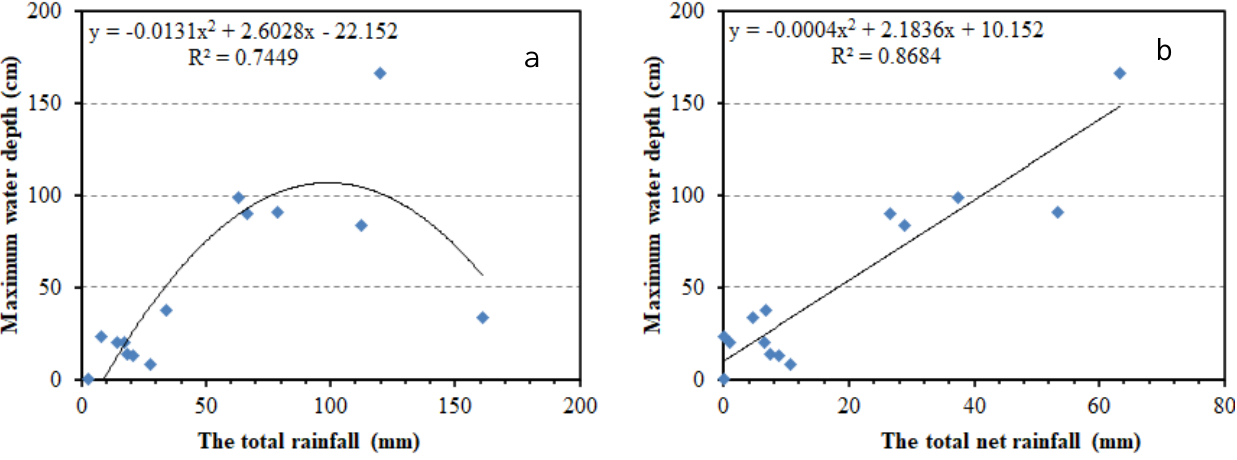
Figure 3. Scatter plots showing ( a ) the relationship between the total rainfall and maximum water depth and ( b ) the relationship between the total net rainfall and maximum water depth in CR tun- nel.